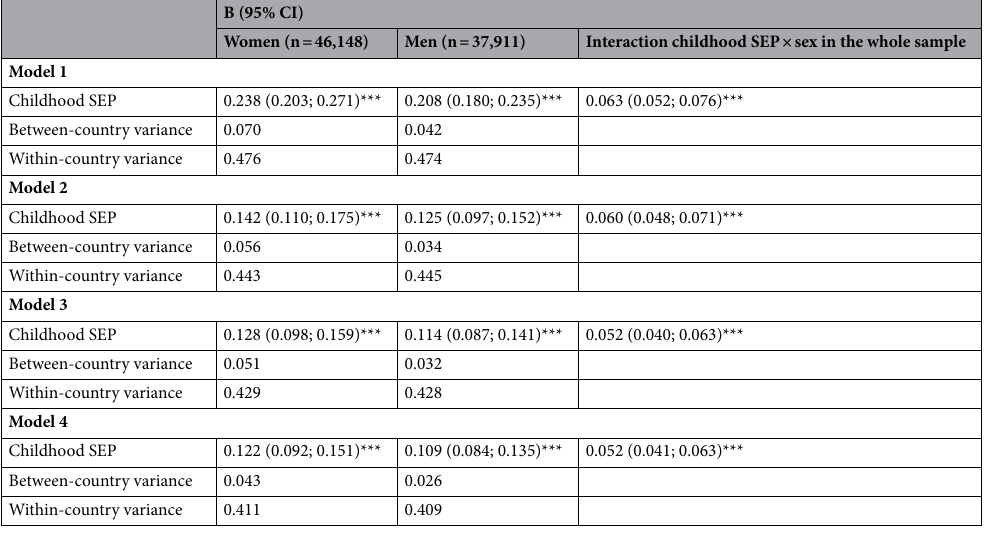
Table 2. Association of childhood socioeconomic position with the level of cognitive performance. * p < 0.05, ** p < 0.01, *** p < 0.001. Results are unstandardized beta coefficients with 95% confidence intervals from multilevel regression models estimating the association of childhood socioeconomic position with cognition. SEP socioeconomic position, CI confidence interval. Model 1 adjusted for age. Model 2 adjusted for age and education. Model 3 adjusted for age, education, depressive symptoms and socioeconomic characteristics (household net worth, cohabitation status, number of children, number of grandchildren and current working status). Model 4 adjusted for age, education, socioeconomic characteristics (household net worth, cohabitation status, number of children, number of grandchildren, current working status) and health related characteristics (body mass index, depressive symptoms, limitations in instrumental activities of daily living, maximum of grip strength, physical inactivity, number of chronic diseases, smoking status, cardiovascular disease and alcohol